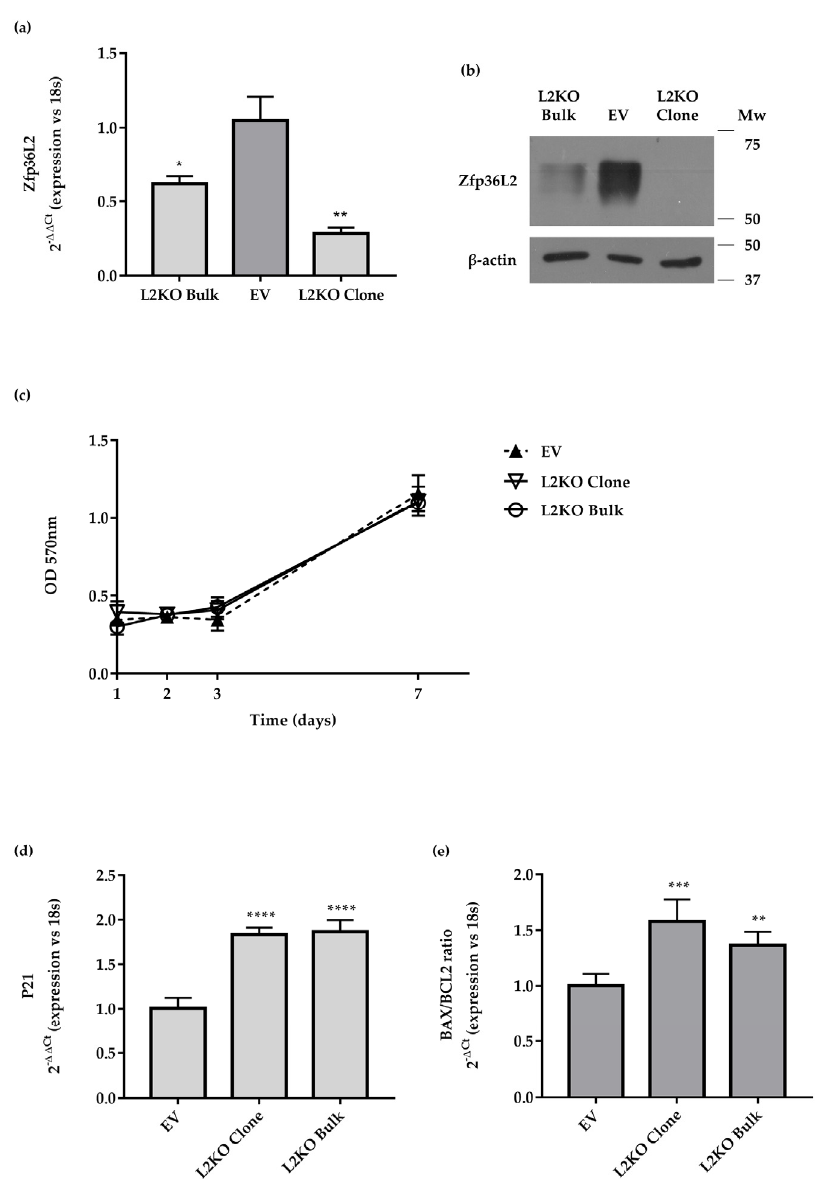
Figure 5. Analysis of the recombinant cell line FRTL5 Zfp36l2 KO. Cells were generated as detailed in M&M by transducing them with lenticrispV2 empty (EV) or carrying a specific gRNA sequence targeting the Zfp36l2 rat gene (L2KO). RTqPCR analysis ( a ) and Western blot ( b ) were conducted to control the knock-out efficiency both in the bulk culture and in one of the selected clones. ( c ) Cell growth of the L2KO cells, bulk culture and clone, and EV were monitored by MTT assay during 7 days of culture in normal medium. RTqPCR analysis of P21 mRNA ( d ), Bax / Bcl2 ratio of the L2KO cells, bulk culture, and clone, vs. EV ( e ). RTqPCR data are reported as mean ± standard deviation of ∆∆ Ct values (FC values of gene normalized vs. FC values of 18SrRNA to obtain ∆ Ct values of samples; ∆ Ct values of KO samples are then normalized vs. ∆ Ct of control samples to obtain ∆∆ Ct values) in KO ( n = 3) and controls ( n = 3). RTqPCR Bax / Bcl2 ratio between mean and standard deviation of Bax and Bcl2 ∆ Ct values (FC values of each gene vs FC of 18SrRNA), in KO ( n = 3) and controls ( n = 3). * p < 0.05; ** p < 0.005; *** p < 0.001; **** p <